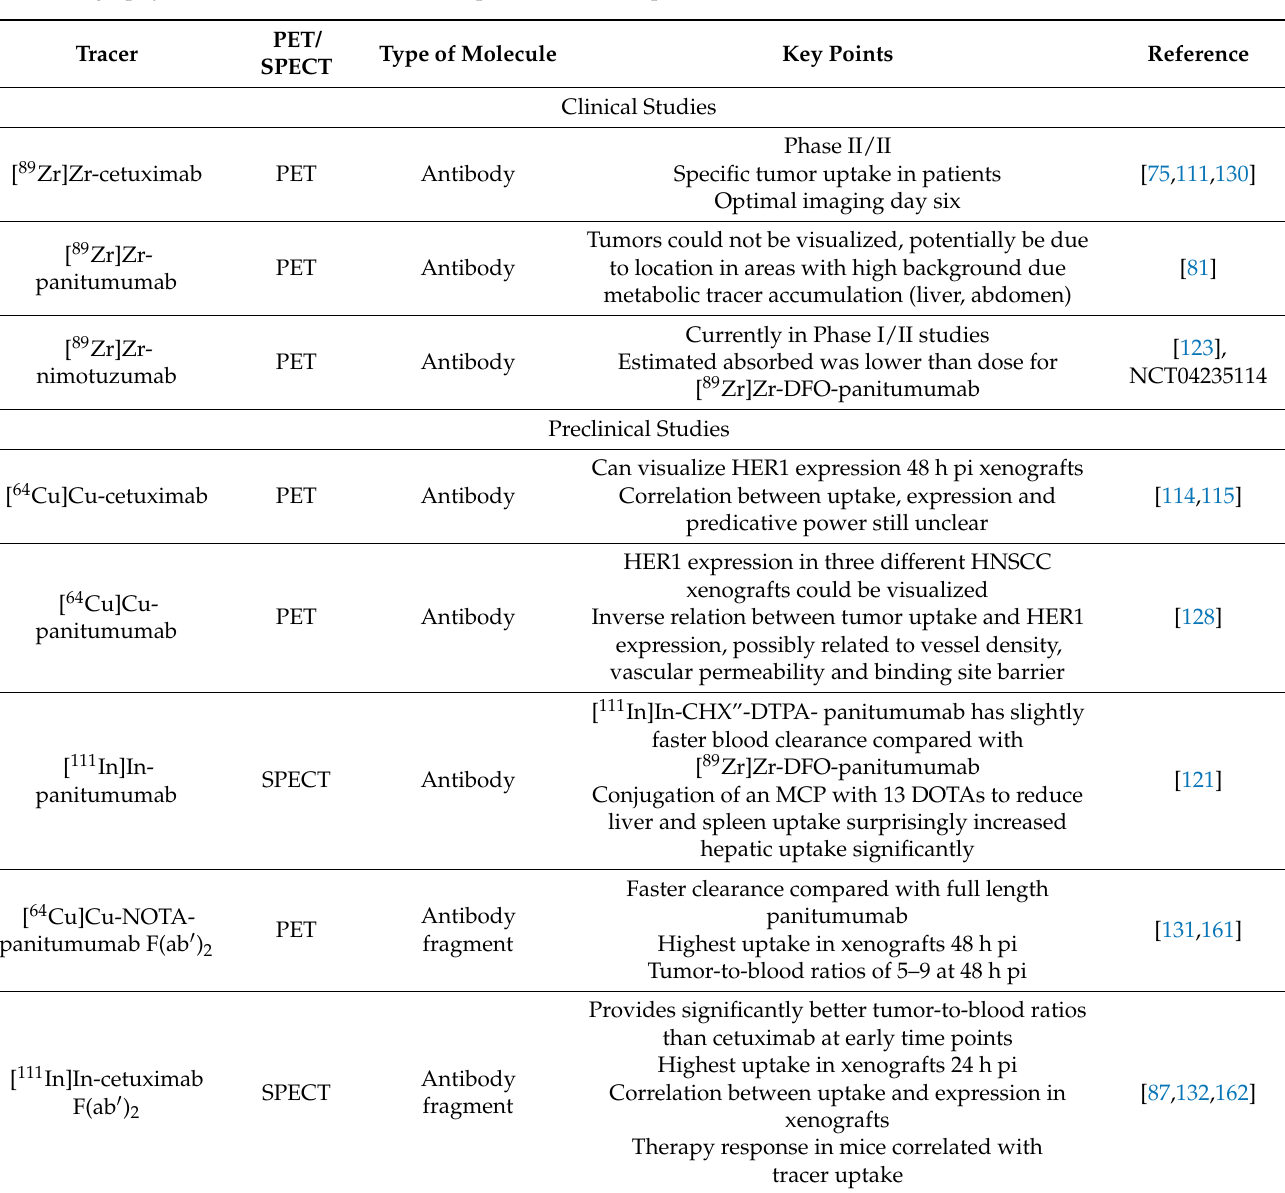
Table 1. Overview of the most promising HER1-targeting Positron Emission Tomography (PET) and Single Photon Emission Tomography (SPECT) tracers in clinical and preclinical development. Tracer Key Points Reference Clinical